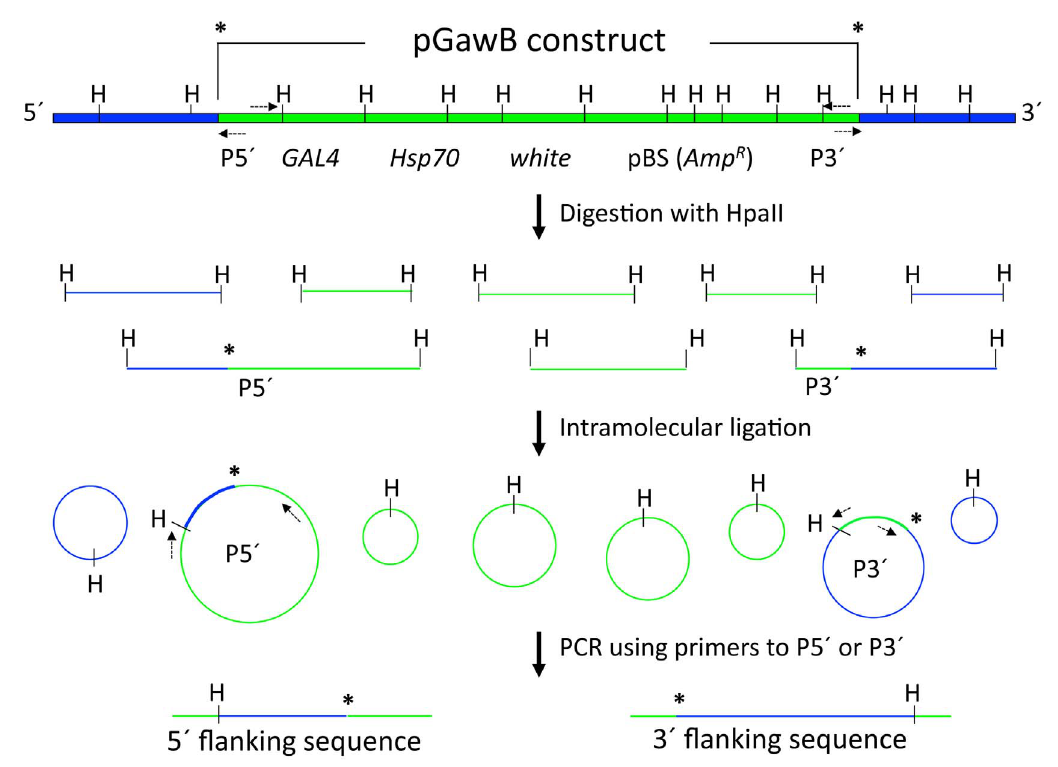
Fig. 3. Inverse PCR from pGawB insertion. Genomic DNA from a GAL4 enhancer trap strain containing integrated pGawB (p-element engineered to contain GAL4 ) is digested with a frequent cutter, HpaII, and the resulting fragments are circularized by intramolecular ligation. Primers (dashed arrows) designed against either the 5 9 or 3 9 ends of the pGawB construct (green) will selectively amplify the flanking genomic DNA (blue). Asterisk: junction between pGawB and flanking genomic DNA. GAL4: GAL4 coding sequence. H: HpaII site. Hsp70: Hsp70 promoter sequence. P3 9 : 3 9 end of p-